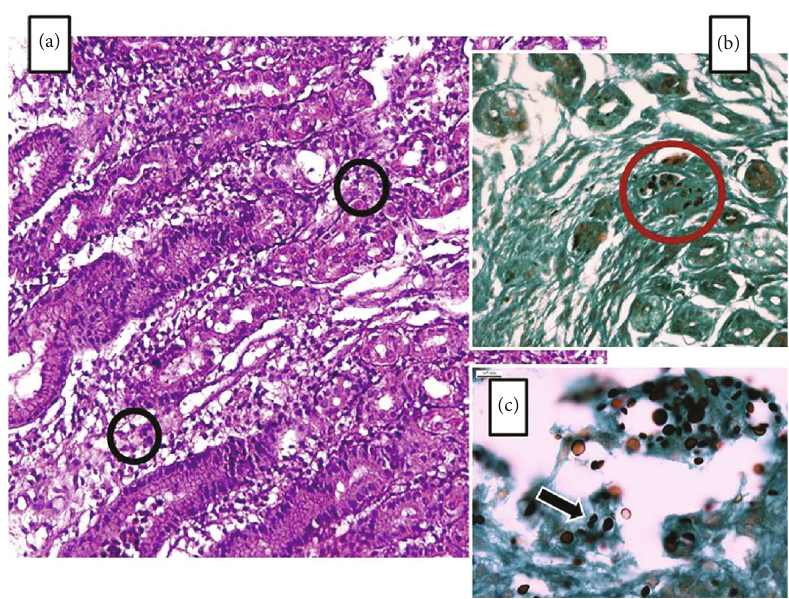
Figure 6: Histopathological specimen of an HIV patient diagnosed with gastric Cryptococcosis. An H&E stain demonstrates oxyntic glands in the body of the stomach with signi fi cant edema and lymphoplasmacytic in fl ammation of the lamina propria (a). Di ff erent-sized round structures with a halo clearing of each pathogen can be seen (black circles). GMS staining demonstrates various sized yeast-like structures (red circle in (b)). Higher-resolution GMS staining ( × 400) highlights organisms with a narrow-based budding consistent with Cryptococcus spp. (c). (Images obtained with permission from Eyer-Silva et al.